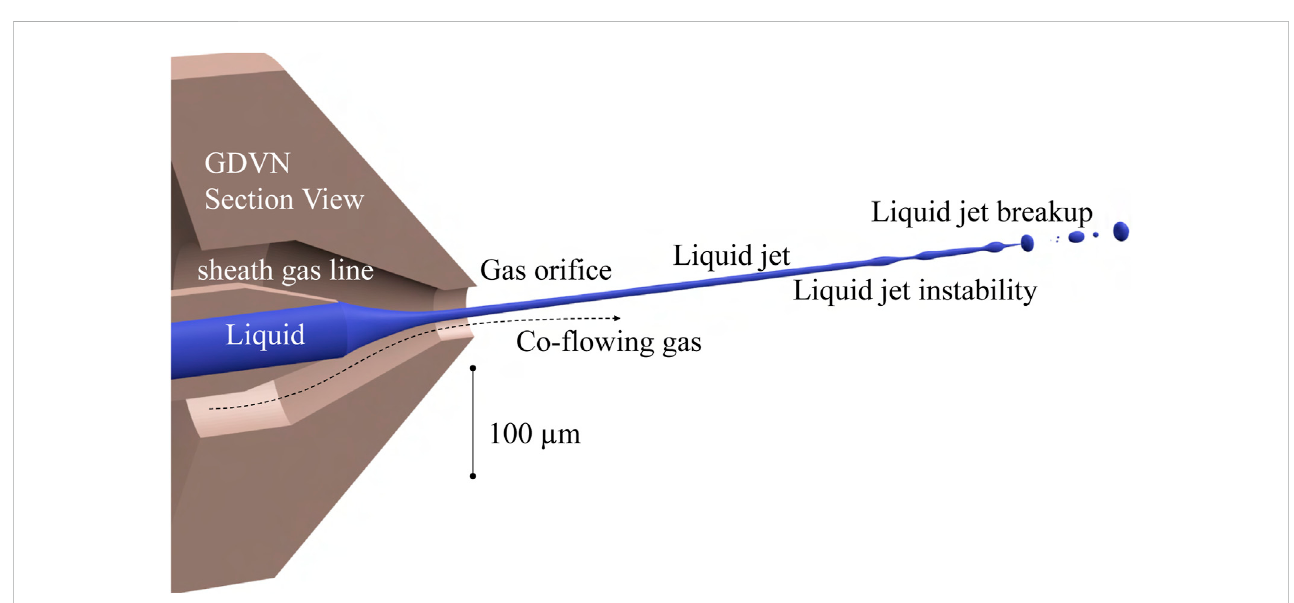
FIGURE 1 Gas-dynamic virtual nozzles (GDVNs) consist of gas focusing the liquid from the liquid line to a thin microjet. This jet experiences jet instability and eventually collapses into